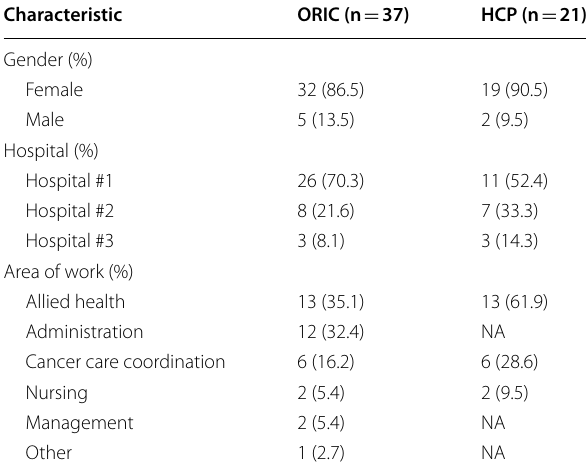
Table 4 Demographic characteristics of baseline ORIC and HCP survey